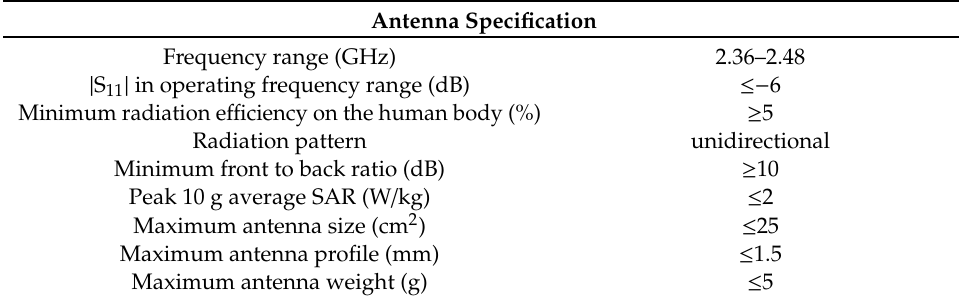
Figure 1. Block diagram of the design, optimization, fabrication and measurement process of small antennas for W-WSNs. Table 1. Target antenna parameters and characteristics.